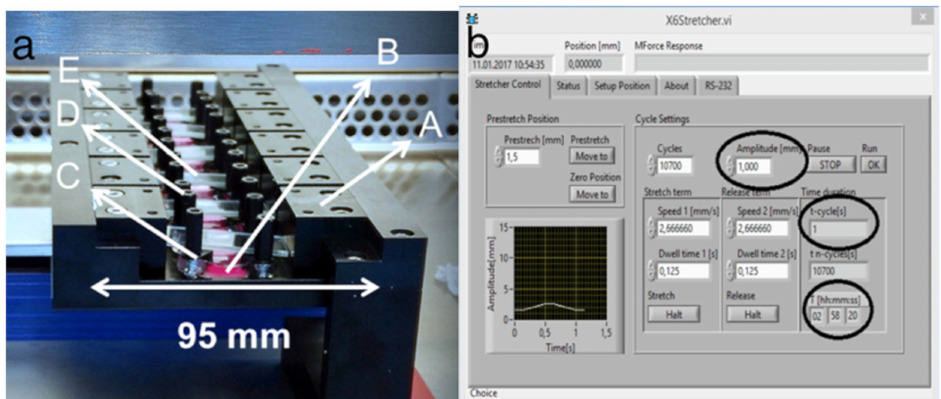
Figure 8. Structure of Cell Stretcher X6 and calibration. Build-up of the X6 stretching device ( a ): A) frame; B) populated silicon chambers with medium; C) Chamber angle; D) Fixing bolts; E) Cover glasses on the left. The manual calibration of the Cell Stretcher X6 with a metal plate on 95 mm as zero position is shown. The calibration was carried out via software ( b ). The control parameters for a 5% (1 mm) amplitude and a 1 Hz frequency are shown as an example (enclosed with a circle). The cycle time (t-cycles) for calculating frequency as an inverse was controlled by the speed 1 and 2. The term of stretching was for 3 h (enclosed with a